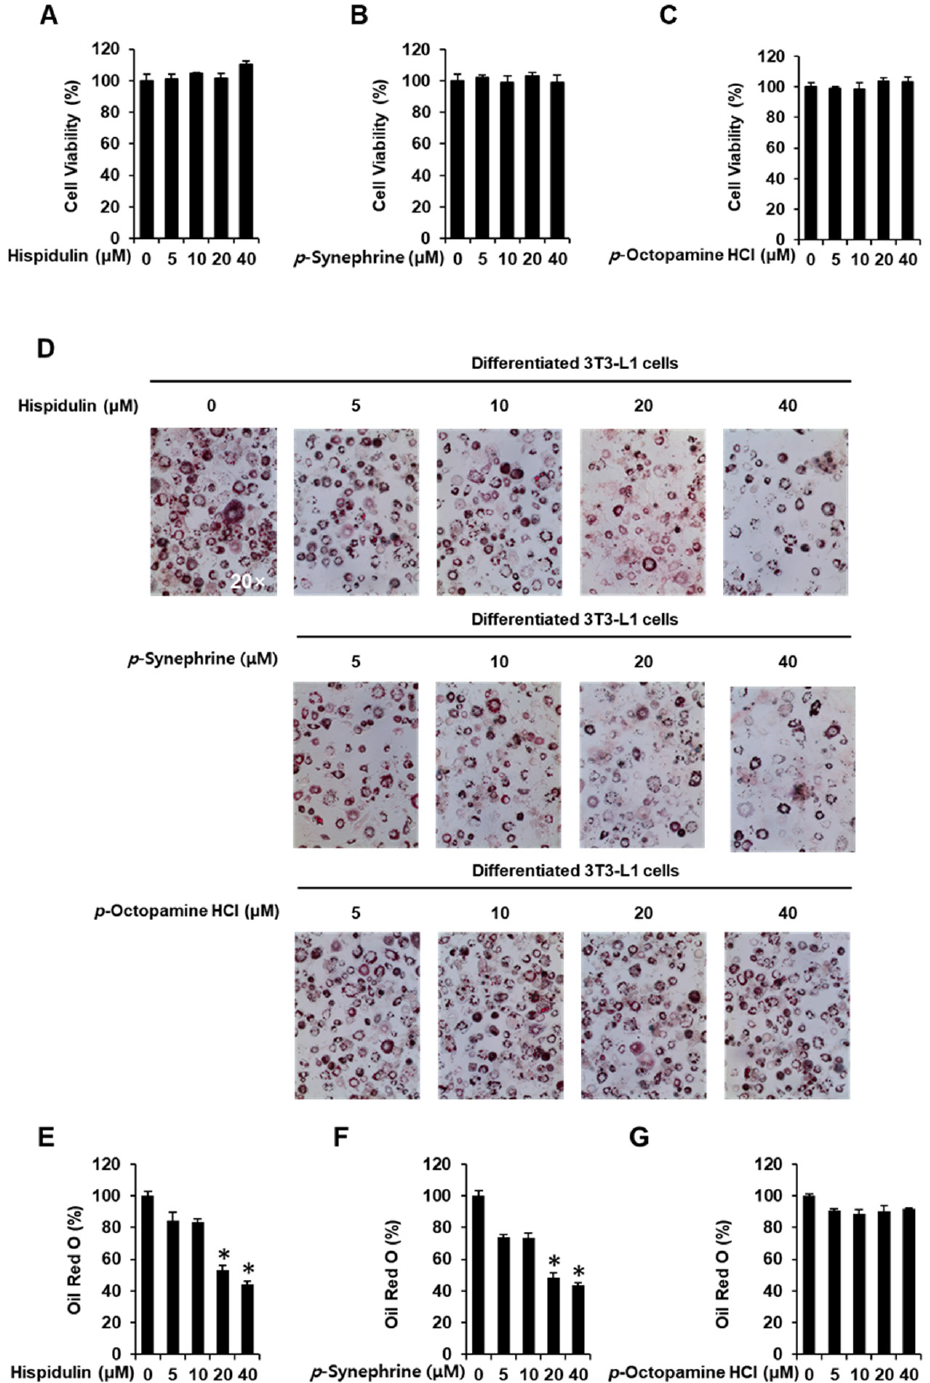
Figure 1. Inhibitory effects of hispidulin, p -synephrine, and p -octopamine HCl on adipogenesis in 3T3L-1 preadipocytes. Effect of ( A ) hispidulin, ( B ) p -synephrine, and ( C ) p -octopamine HCl on the viability of 3T3L-1 cells for 8 days using an Ez-Cytox cell viability assay. ( D ) Images of Oil Red O (ORO) staining of differentiated 3T3L-1 cells were produced using an inverted microscope at 20- fold magnification on day 8 after treatment with hispidulin, p -synephrine, and p -octopamine HCl. ( E – G ) Quantification of ORO staining as percentage of untreated control (three independent repli- cates; * p < 0.05, Kruskal–Wallis nonparametric test). Data are shown as means ± standard error of the mean (SEM).